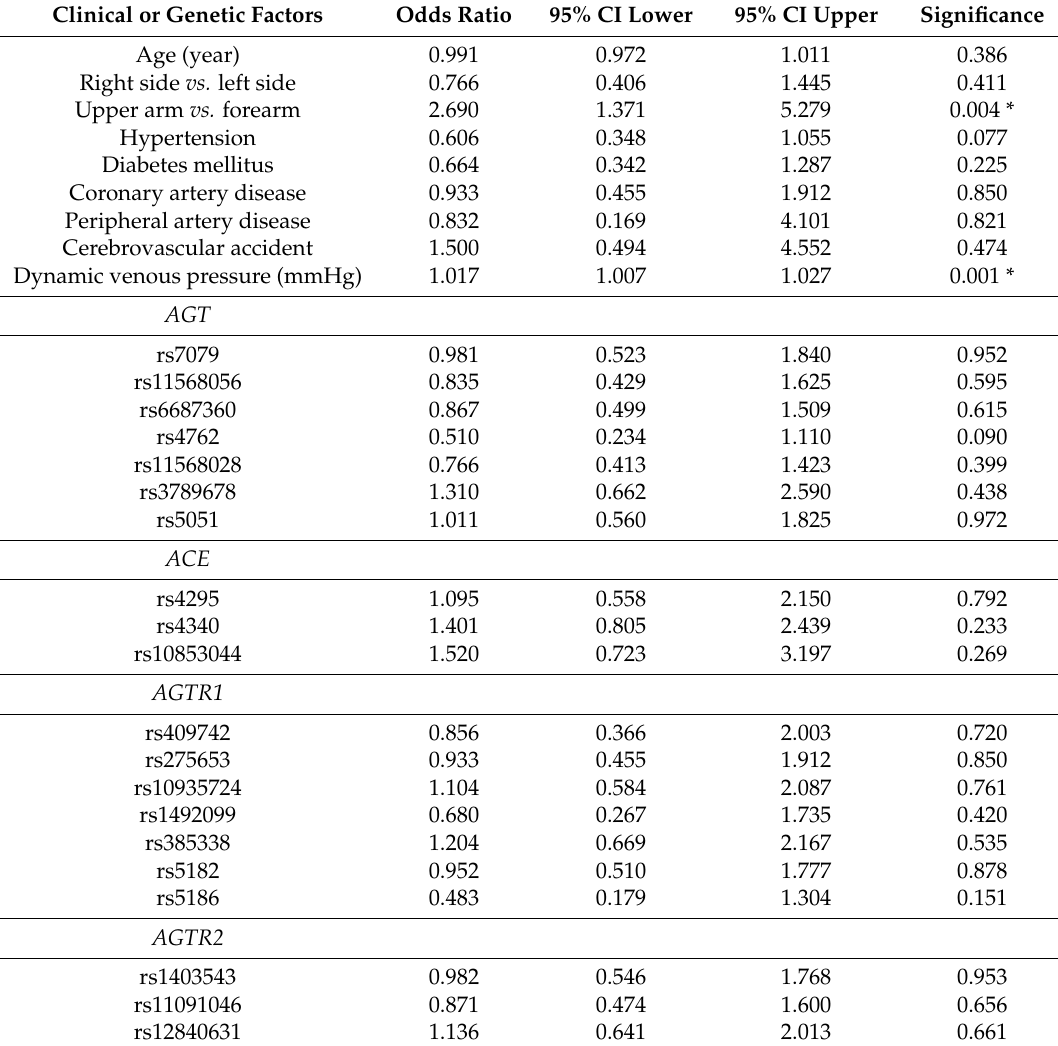
Table 4. Univariate logistic regression model of factors associated with AVF malfunction in female HD